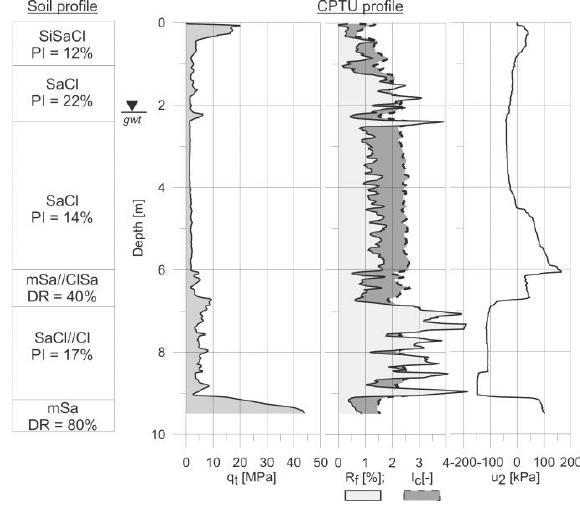
Figure. 1. Location of the test site in Poland. Figure 2. Typical soil and CPTU profile of the test site. Figure 2: Typical soil and CPTU profiles of the test